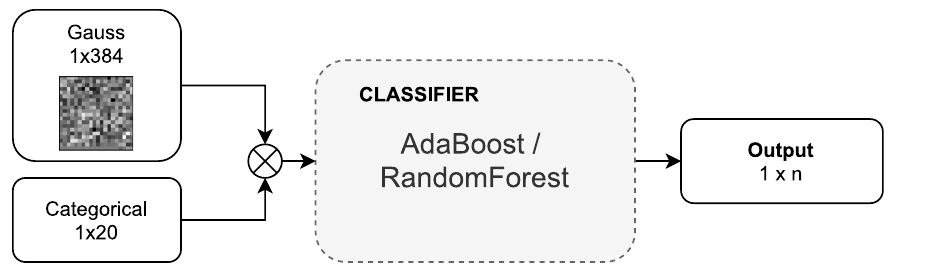
Fig 4. Classification of masked images using Ada Boost and Random Forest